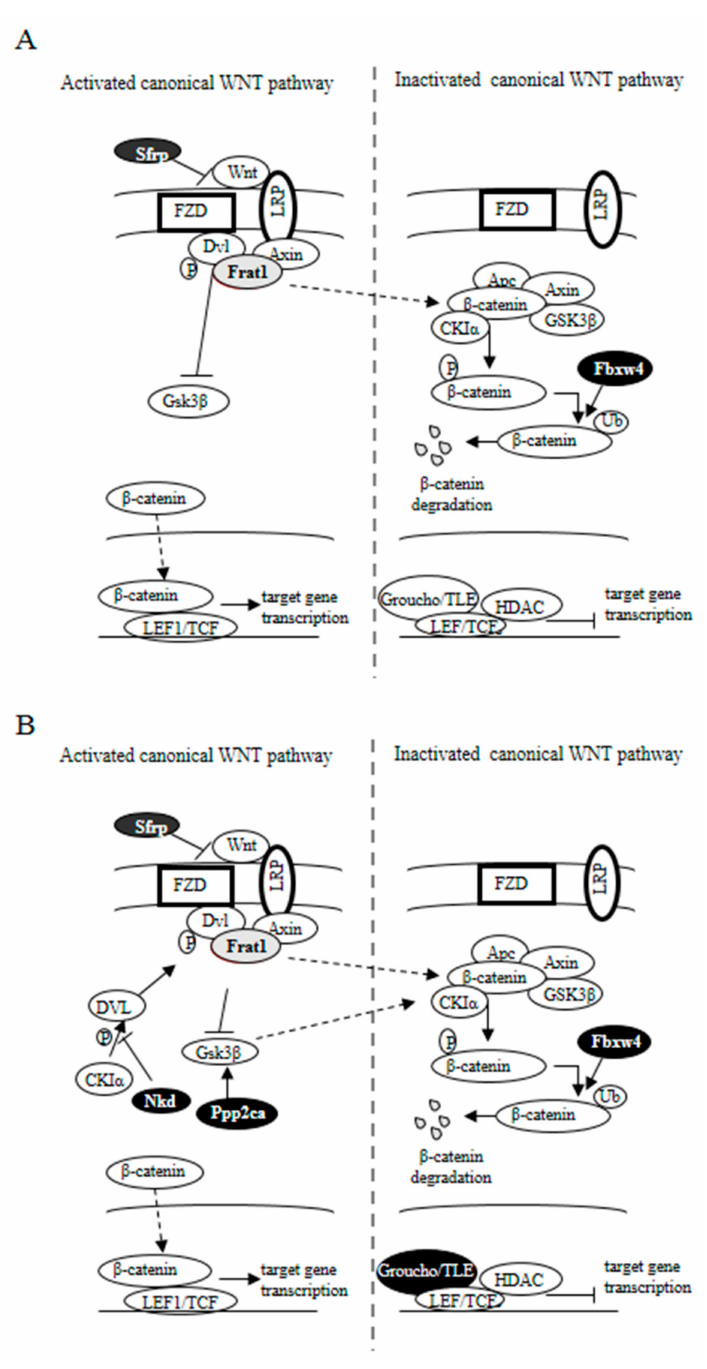
Figure 7. Effect of supplemented diets on the Wnt signaling pathway in APC Min/+ mice. Genes whose expression augmented as a result of dietary supplementation are represented with black-filled ovals, while those whose expression decreased are represented in grey. ( A ) APC Min/+ mice fed with a ( Bf + Lg ) supplemented diet (E1 group). ( B ) APC Min/+ mice fed with a ( Bf + Lg +Q) supplemented diet (E2 group). Solid arrow indicates confirmed interaction between proteins; dashed arrow indicates suggested